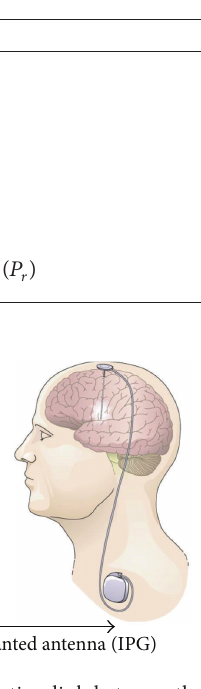
Figure 7: The layout of communication link between the external transmitter and the implanted receiving antenna for the energy harvesting performance